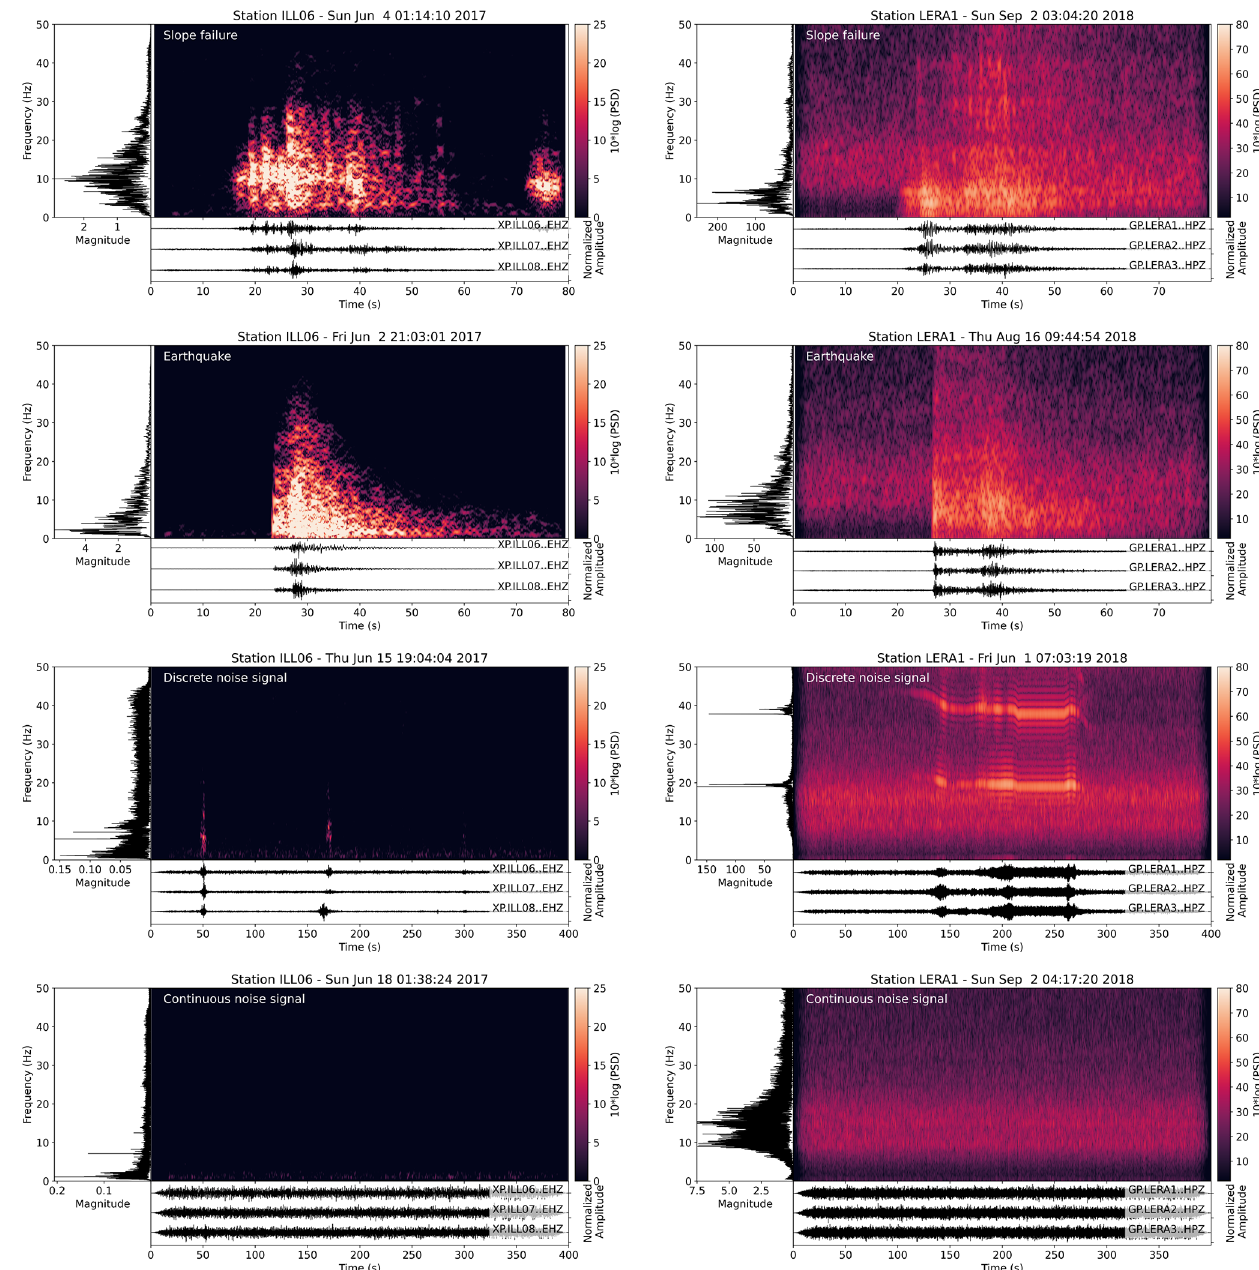
Figure 2. Waveforms, spectrogram, and spectra of example events for each class recorded at Illgraben (left panels) and Pizzo Cengalo (right panels). Spectrograms have been computed with a window length of 128 samples, an overlap of 120 samples, and an FFT length of 2048